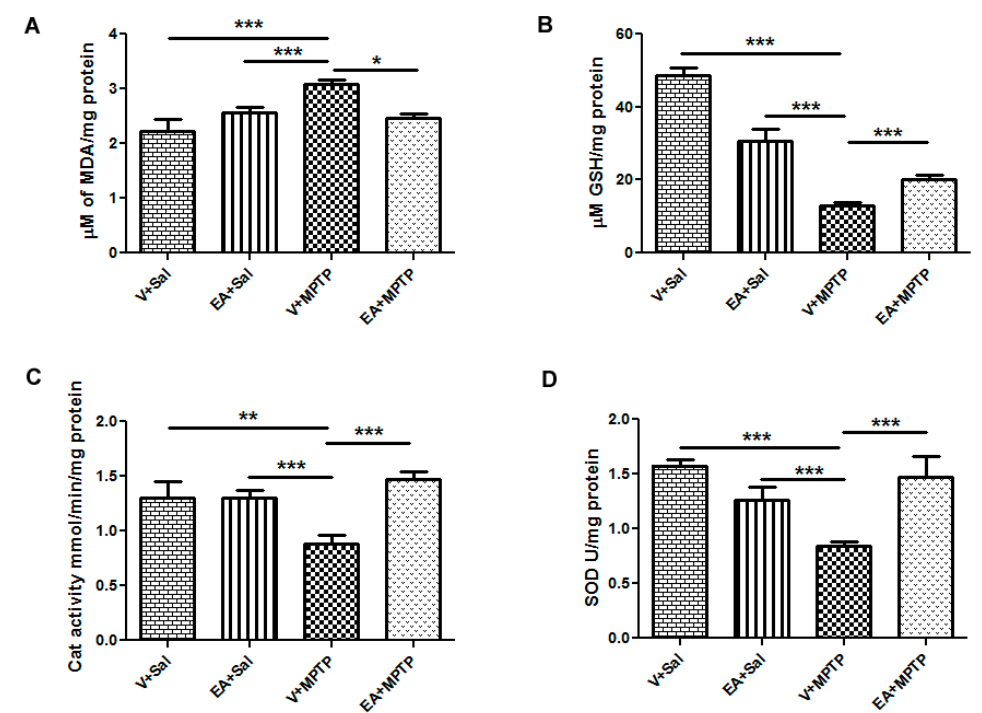
Figure 2. Estimation of malondialdehyde (MDA), glutathione (GSH), catalase, and superoxide dismutase (SOD) in the striatum tissue of different experimental groups. The MPTP injection increased the lipid peroxidation product, malondialdehyde (MDA) ( A ) and decreased the total glutathione (GSH) level ( B ) in the striatum tissue of mice relative to the control (Vehicle + Saline) group. MPTP injections also significantly decreased the activity of catalase ( C ) and SOD ( D ). Ellagic acid (EA) treatment prior to MPTP significantly increased the activities of the antioxidant enzymes SOD and catalase. It significantly reduced the level of MDA and increased the level of total GSH. Values are expressed as mean ± SEM ( n = 4–5). Significance is denoted as * p < 0.05, ** p < 0.01 and *** p < 0.001.